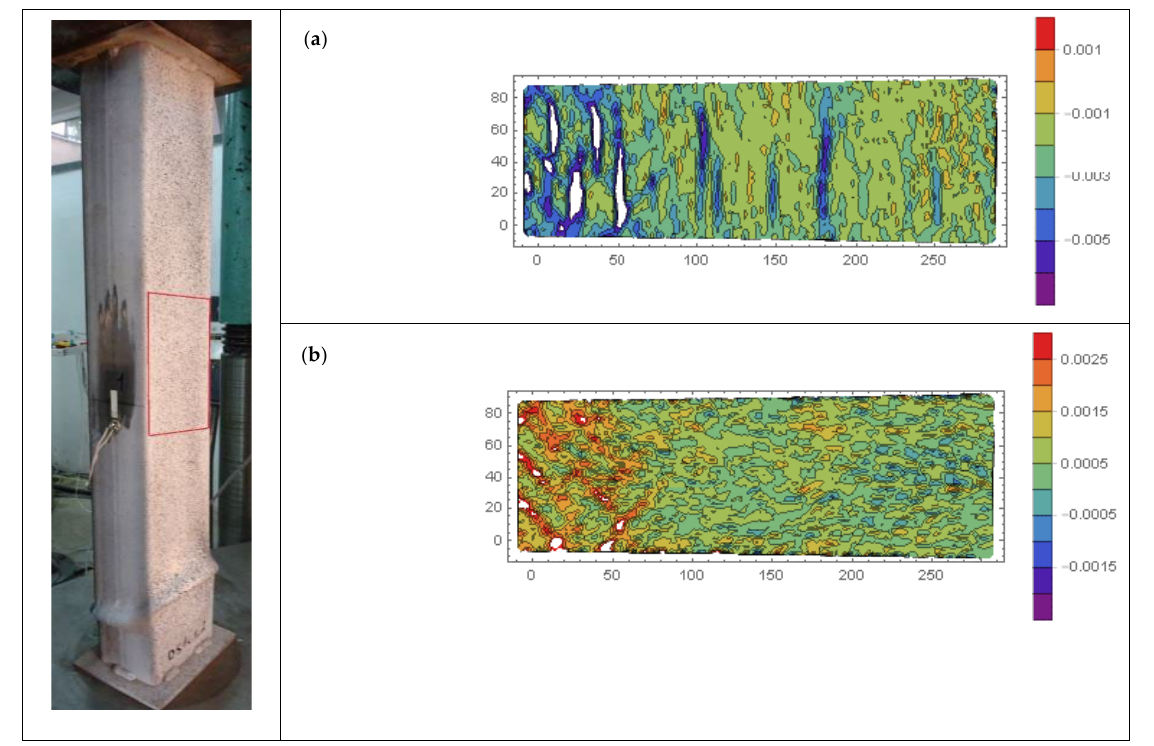
Figure 21. ( a ) Longitudinal ε xx and ( b ) transverse ε yy strains in column DS1C1_2 captured in the same point of the equilibrium path.